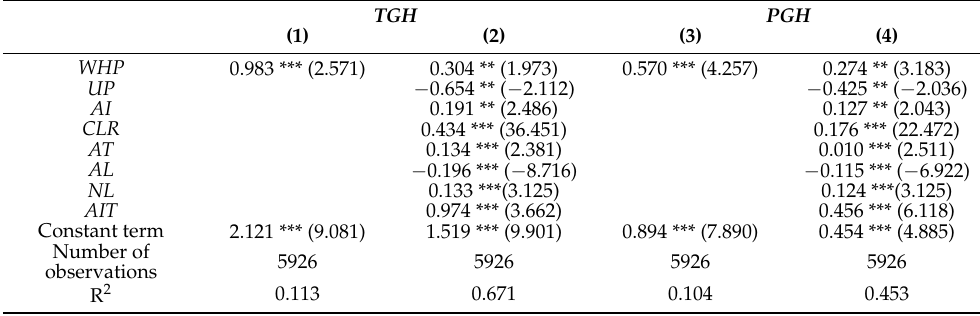
Table 4. Test results of the average effect of rural households’ part-time farming on grain output. TGH PGH